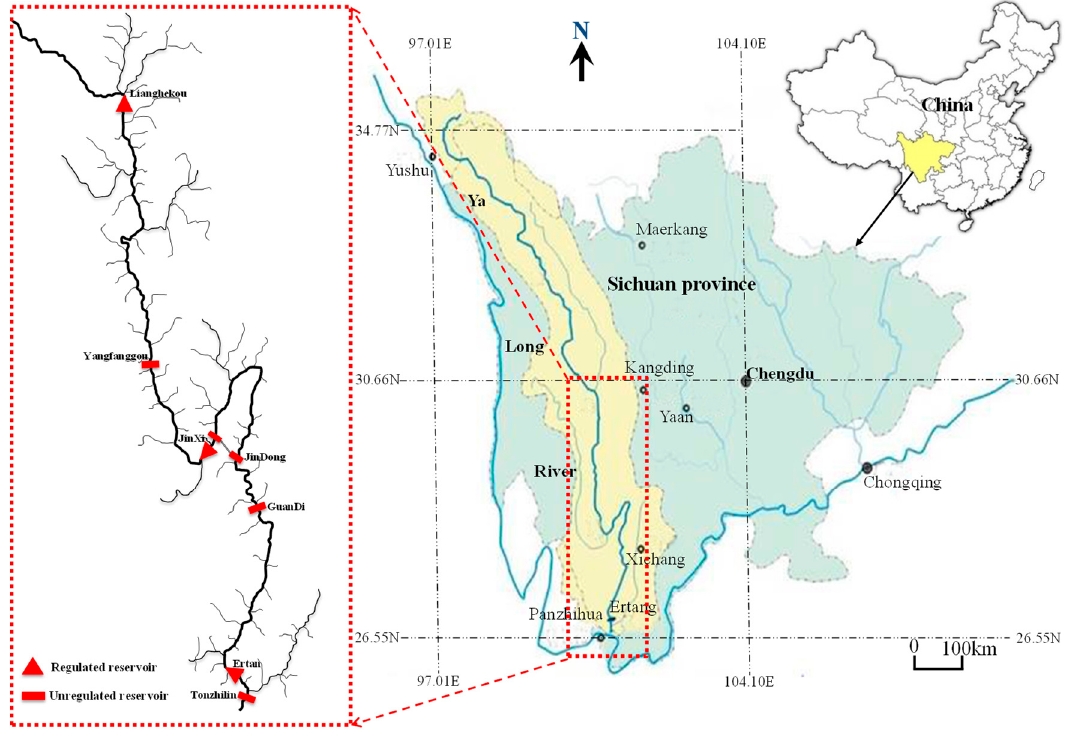
Figure 6. Geographical location of the 7 reservoirs in Yalong River basin.